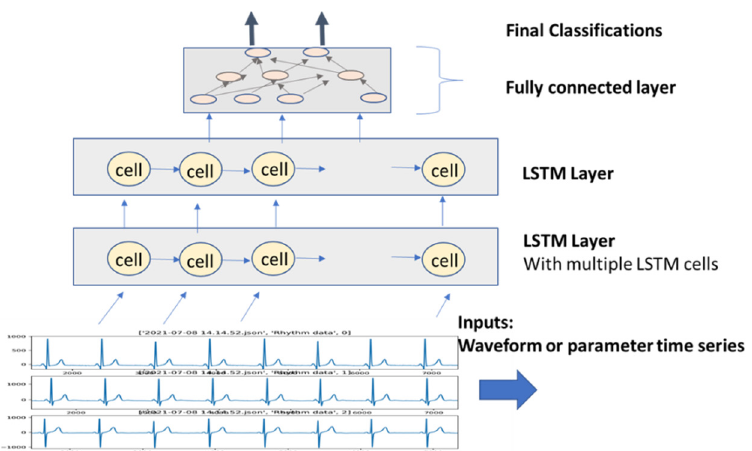
Figure 7. RNN model includes one or multiple RNN layers with multiple cells in each layer. Here, LSTM cells are used. The input of RNN is a series of ECG waveforms or ECG parameters, e.g., R-R intervals or P-R-T components. The last block of the model consists of fully connected layers. The final output can be either binary or multiple